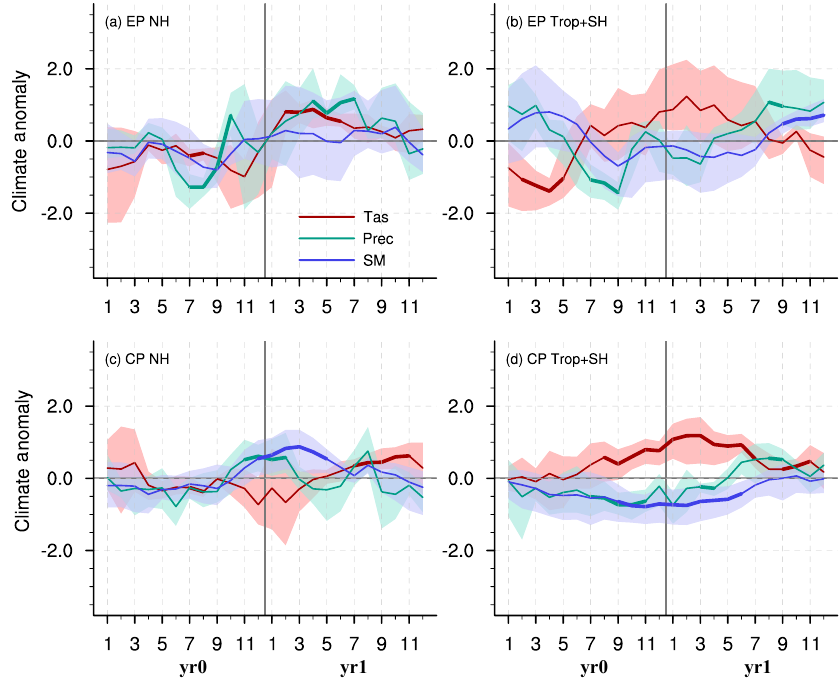
Figure 5. Composites of the standardized land surface air temperature (Tas, red lines), precipitation (green lines), and TRENDY-simulated soil moisture content (SM, blue lines) anomalies in two types of El Niños over the NH and over Trop + SH. The shaded area denotes the 95% confidence intervals of the variables in the composite, derived from 1000 bootstrap estimates. The bold lines indicate the significance above the 80% level estimated by the Student’s t